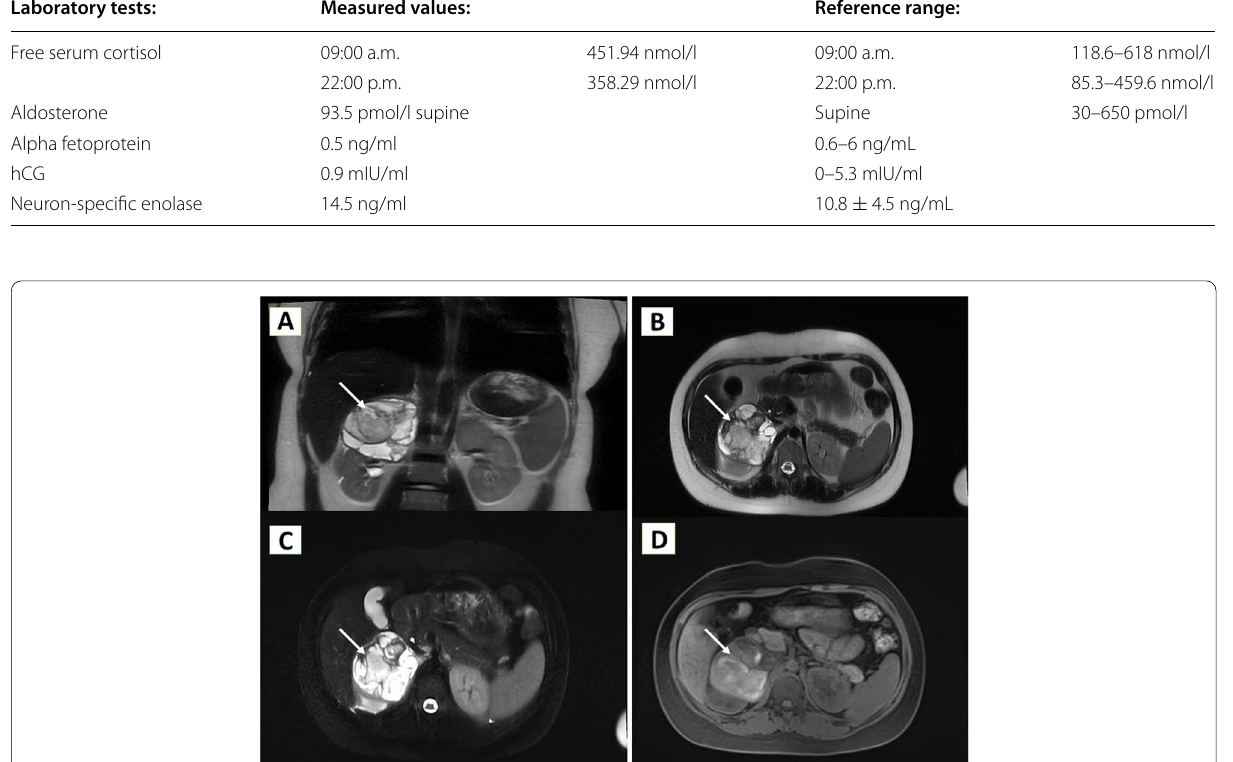
Fig. 2 A T2-weighted, coronal view. B T2-weighted, axial view. C Fat suppressed sequence, axial view. D Gadolinium enhanced T1, axial view. The formation shows strongly heterogeneous MR-characteristic, mainly cystic (T2-hyperintense) and with hemorrhagic content (T1-hyperintense); there is presence of a relatively thick capsule (possibly a pseudocapsule due to a highly thin and peripherally dislocated parenchyma) and fine septa. After application of contrast material, there is an amplification of the signal at the periphery (capsule/pseudocapsule) of the lesion and in the septa. Mass effect on the upper pole of the right kidney, right hepatic lobe, inferior vena cava, and right renal vein is